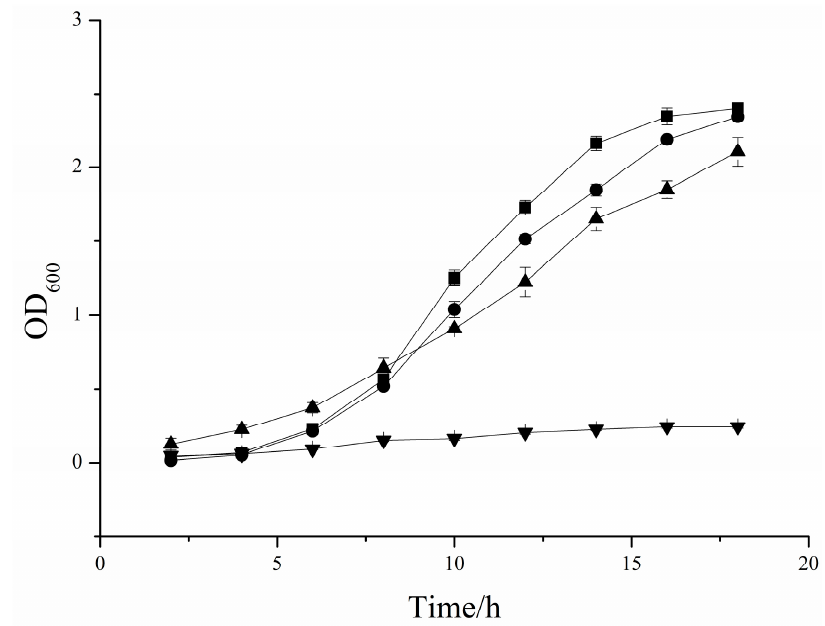
Figure 2. Effects of 500 mg/L COS on the cell growths of Saccharomyces cerevisiae and Pichiapastoris during winemaking that were determined by using the optical density (OD) valuesat 600 nm (OD 600 ). ■ , Saccharomyces cerevisiae withoutCOS; ● , Saccharomyces cerevisiae withCOS; ▲ , Pichiapastoris withoutCOS; ▼ , Pichiapastoris withCOS.